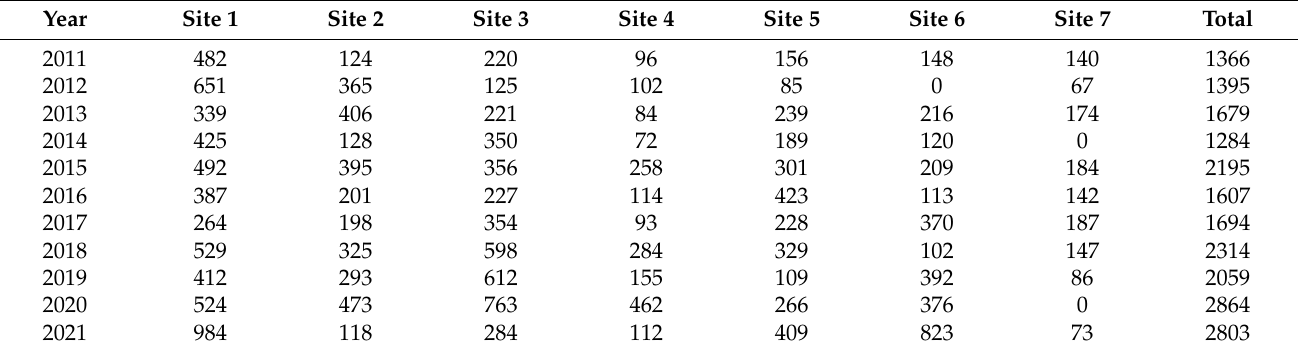
Table 1. Bar-headed goose population size in Caohai from 2011 to